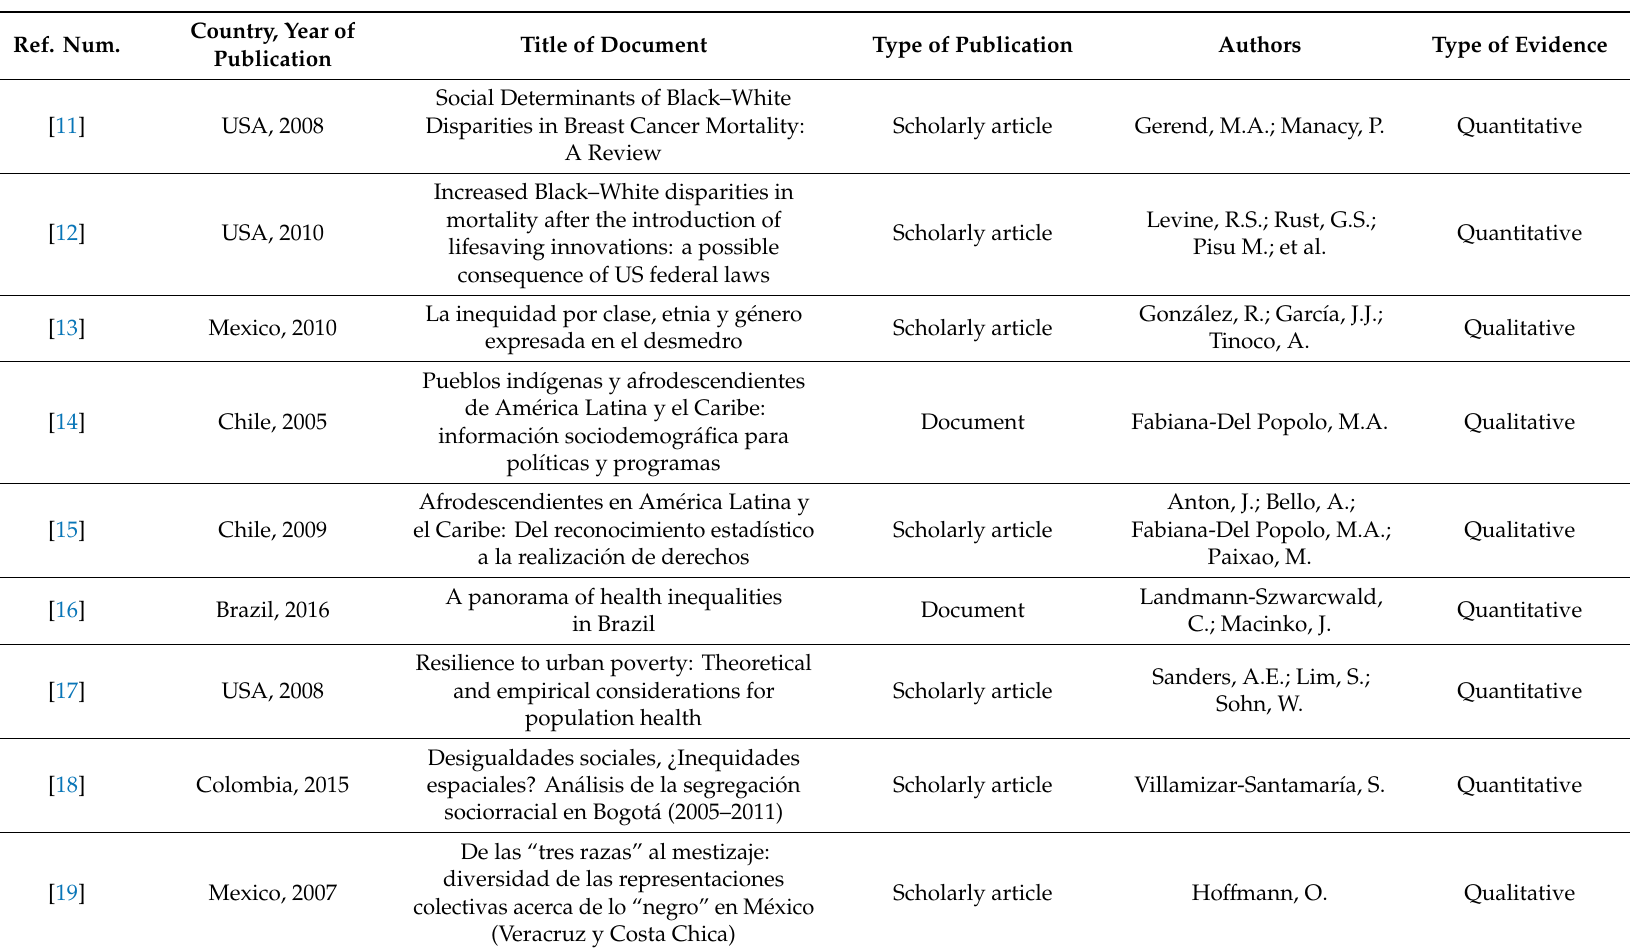
Table 2. Characteristics of the publications included in the systematic exploratory review on health inequalities and people of African descent. Ref.